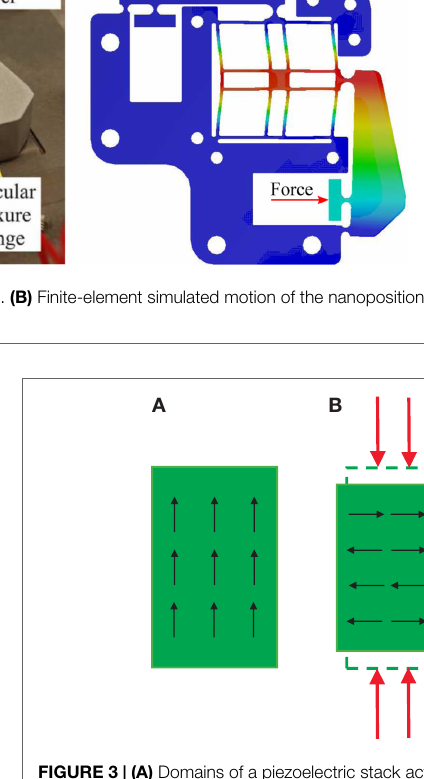
FIGURE 3 | (A) Domains of a piezoelectric stack actuation before preload. (B) Increased amount of non-180° domains after the application of